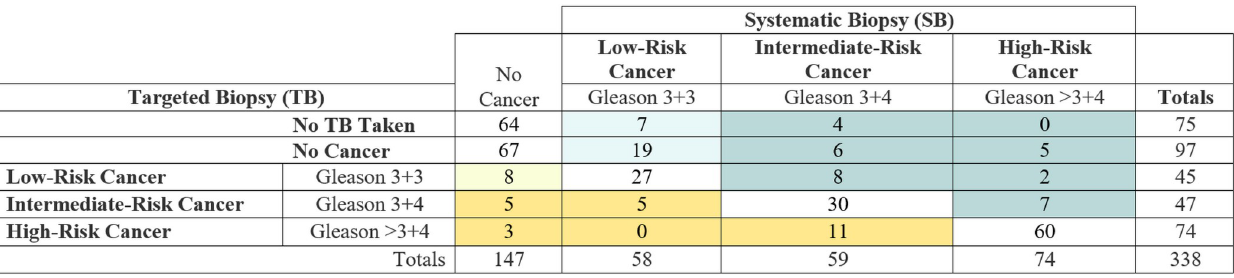
PLOS Medicine| https://doi.org/10.1371/journal.pmed.1002813 June 3,